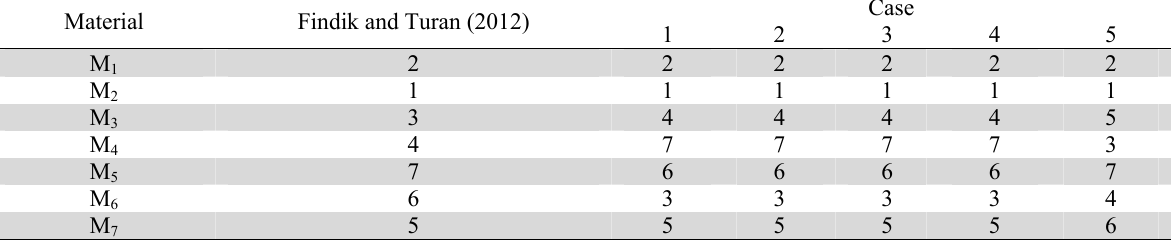
Rankings of light load wagon wall materials using TOPSIS method Material Findik and Turan (2012)